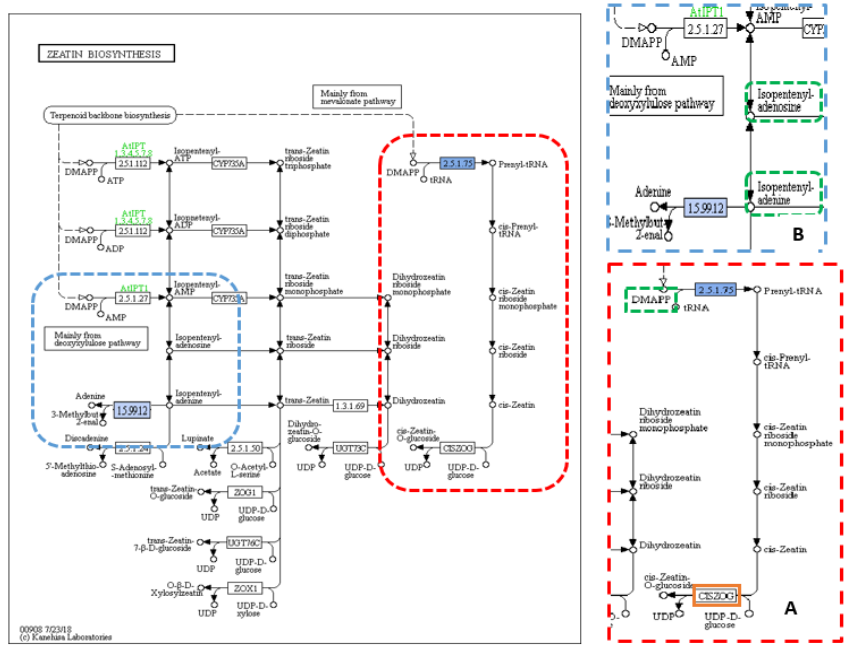
Figure 3. KEGG pathway of zeatin biosynthesis showing ( A ) cis-type cytokinin (CK) biosynthesis and ( B ) cytokinin (CK) signalling pathway. KEGG pathway of zeatin biosynthesis showing ( A ) cis-type cytokinin biosynthesis (dotted red box) and ( B ) cytokinin signalling pathway (dotted blue box), dotted green squares: the precursors and / or substrates included in CK biosynthesis pathway, solid blue square: ( A ) 2.5.1.75 –dimethylallyl transferase enzyme encoded by IPT6 and / or OsIPT4 (isopentenyl pyrophosphate transferases) (LOC107275425 and/or LOC4334529 ) genes carrying the